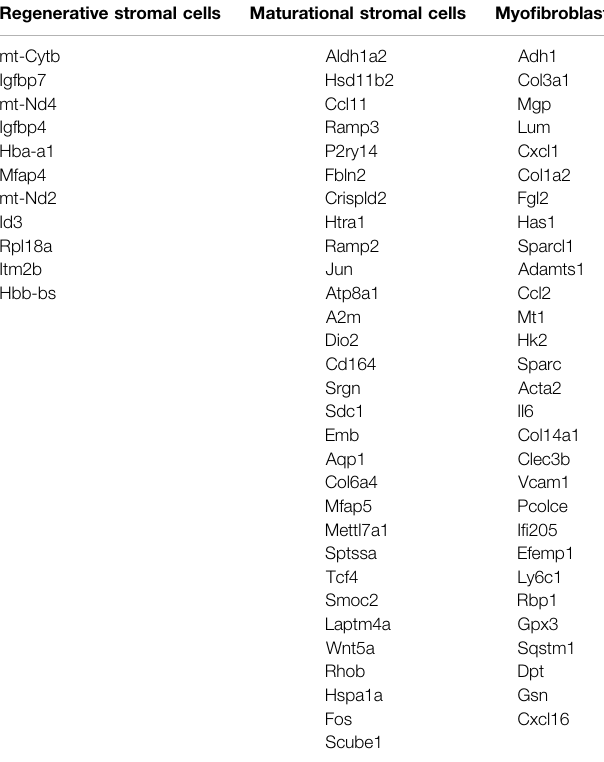
TABLE 1 | Signi fi cant branch-dependent genes of mice stromal cells in different physiological stages. Regenerative stromal cells Maturational stromal